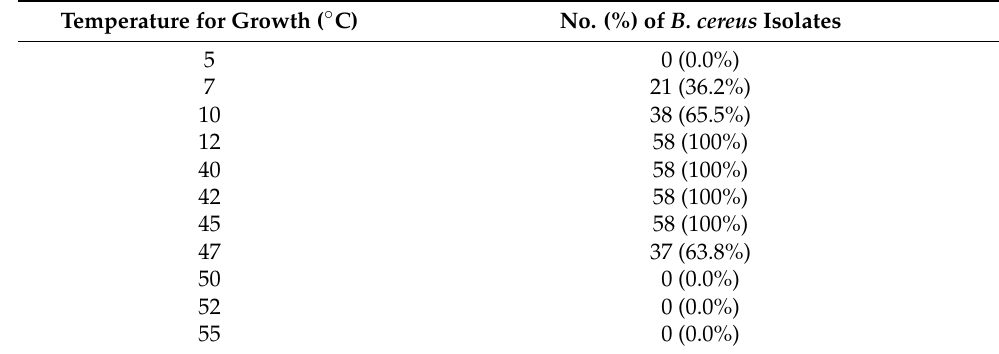
Table 3. Evaluation of the growth ability of B. cereus isolates from chilled tofu at different temperatures. Temperature for Growth ( ◦